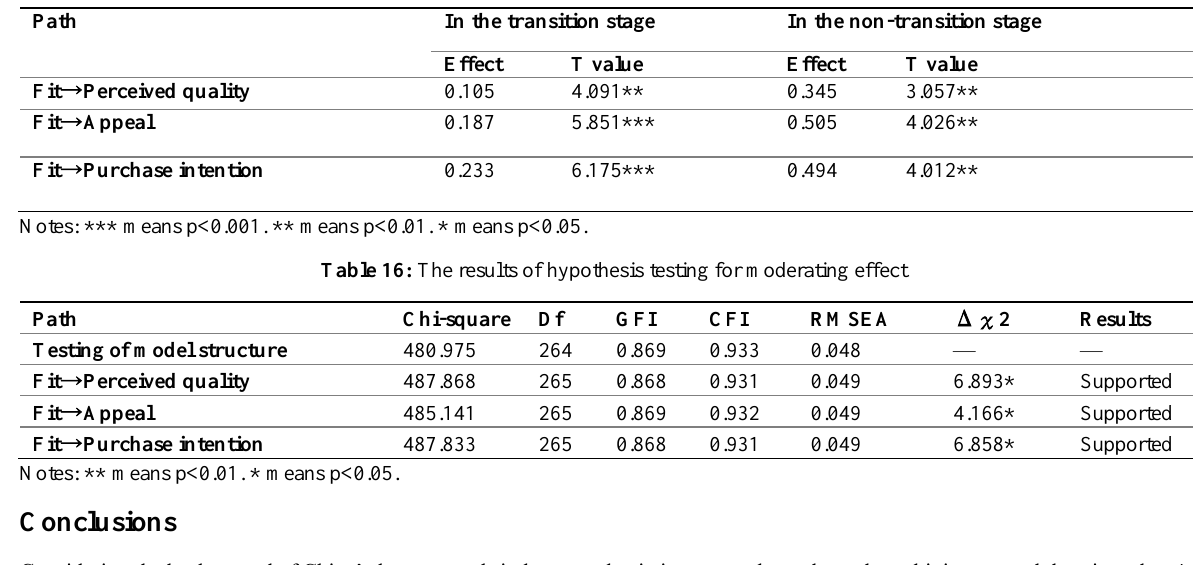
Table 15: The results of hypothesis testing for moderating effect